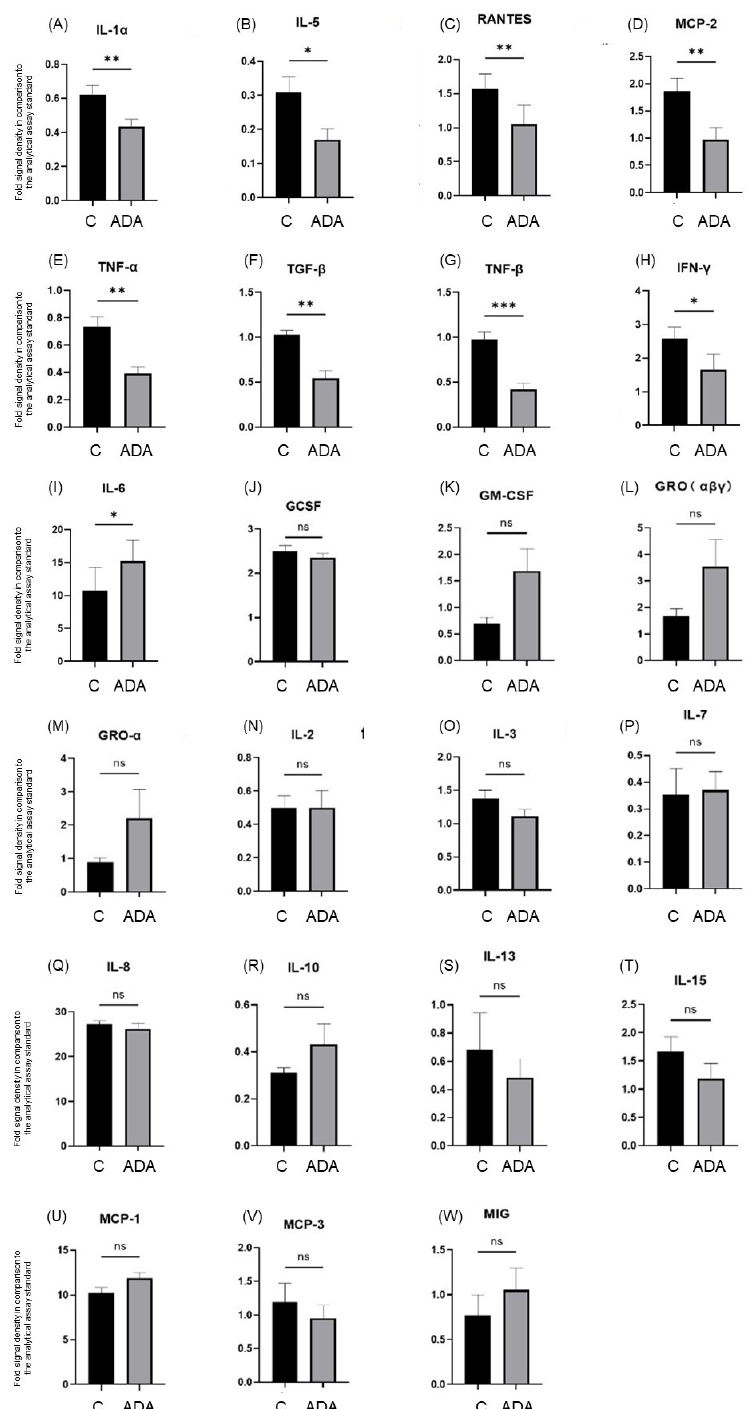
Figure 4. Comparative expression of the levels of IL-1 α ( A ), IL-5 ( B ), RANTES ( C ), MCP-2 ( D ), TNF- α ( E ), TGF- β ( F ), TNF- β ( G ), IFN- γ ( H ), IL-6 ( I ), GCSF ( J ), GM-CSF ( K ), GRO ( αβγ ) ( L ), GRO- α ( M